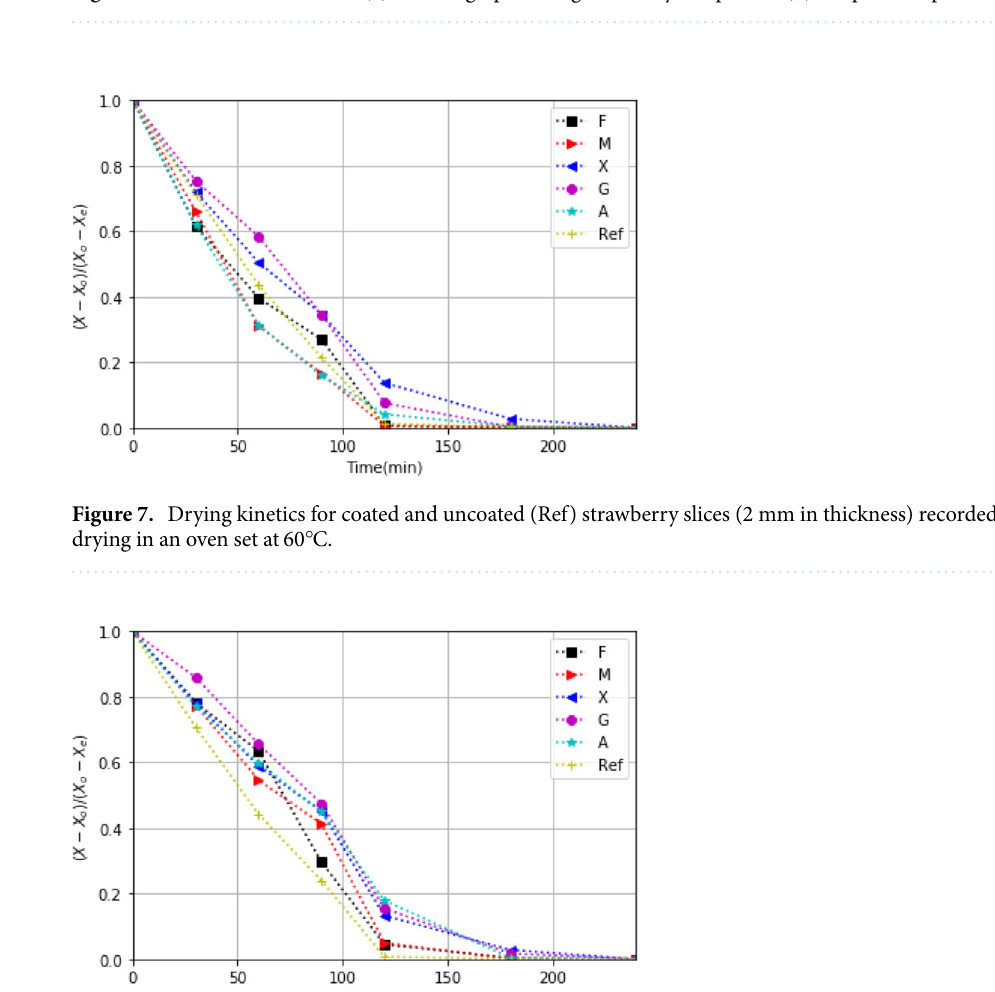
Figure 6. Thermal distribution. ( a ) Thermographic image for every sample and ( b ) temperature profile.